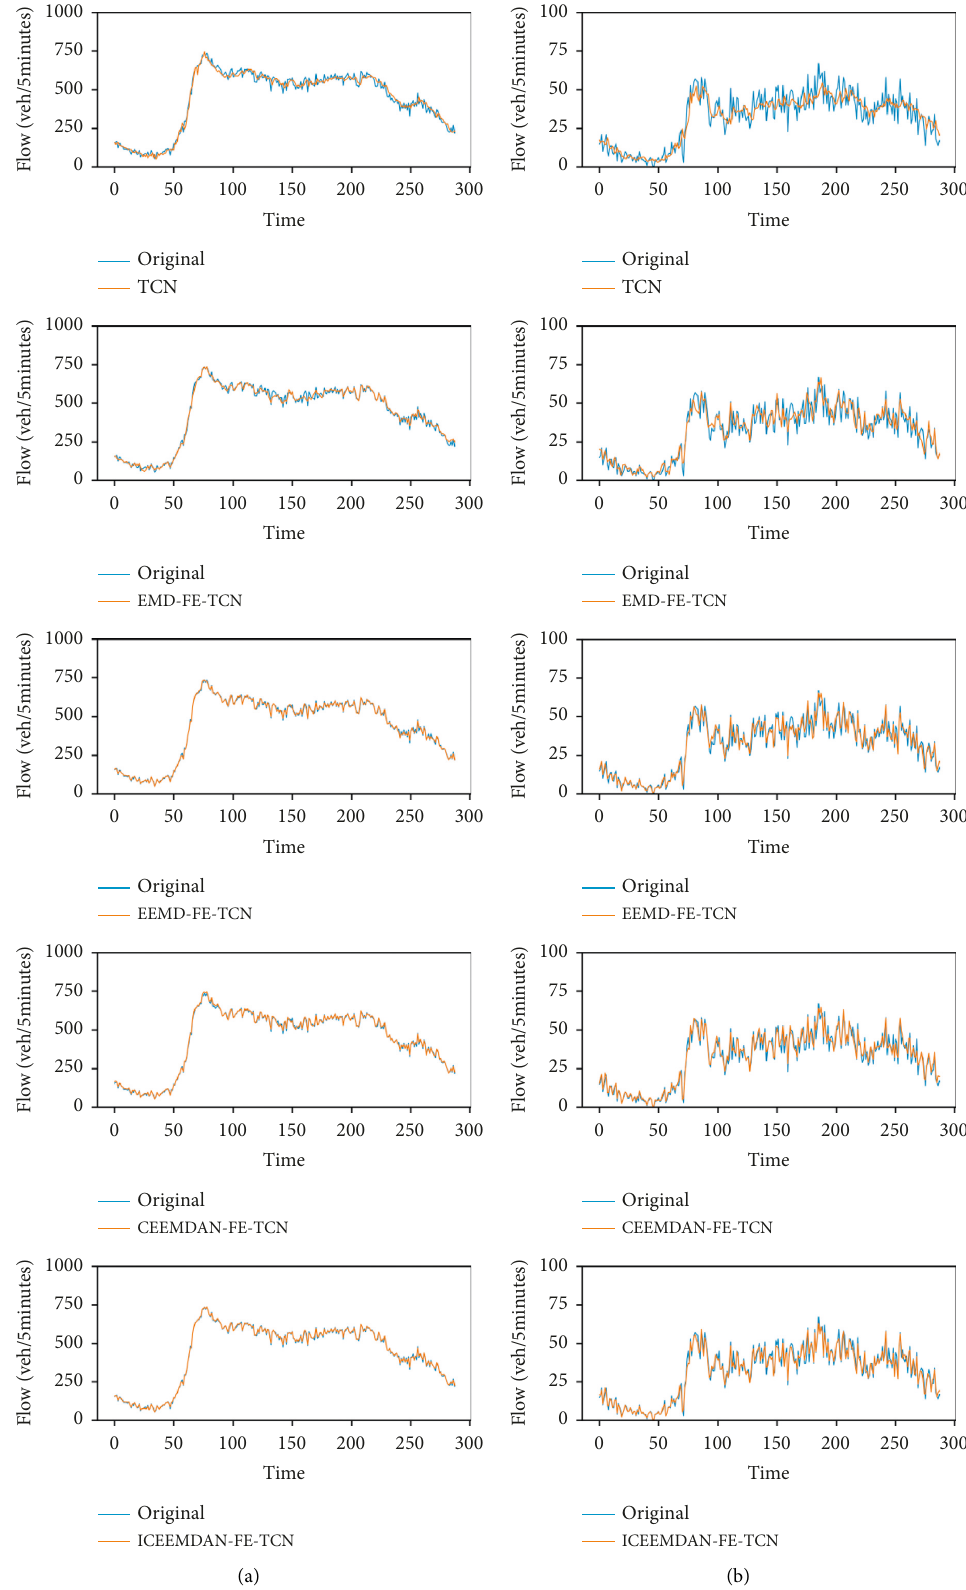
Figure 11: Prediction performance comparison on Aug 31, 2018, of different models based on TCN: (a) 717490 and (b)